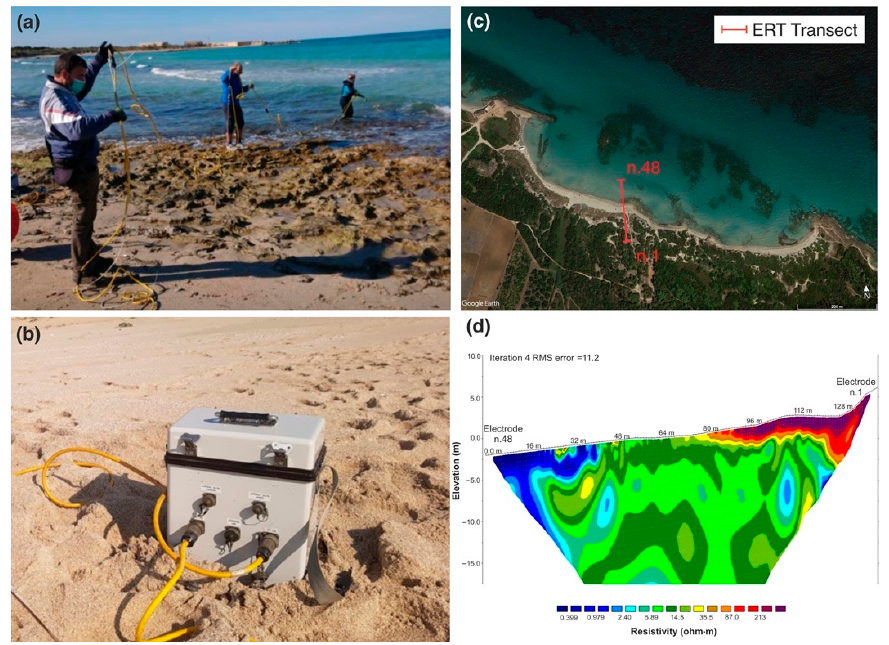
Figure 12. Example of ERT field survey. ( a ) Graphite electrodes positioning; ( b ) instrument for sending current into the ground; ( c ) map showing the ERT transect location; ( d ) resistivity model.